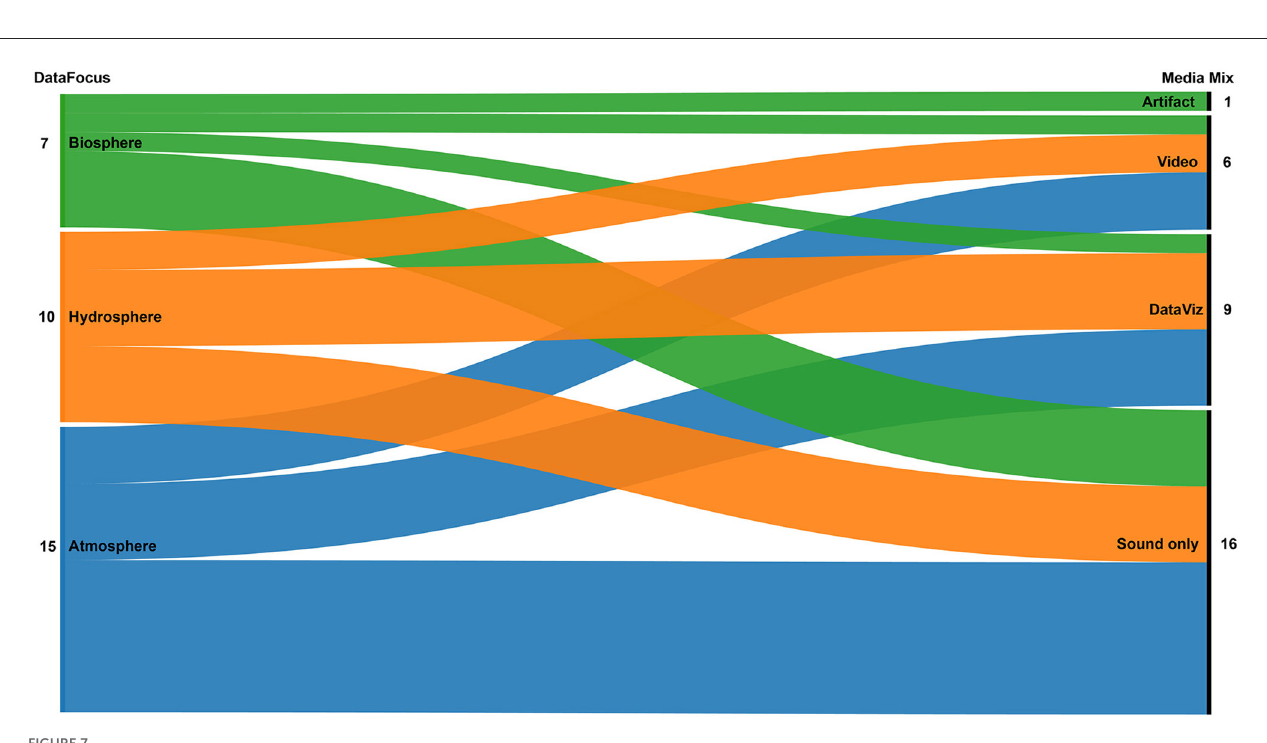
through metaphor. The association might be more or less graspable, hypothetical, or